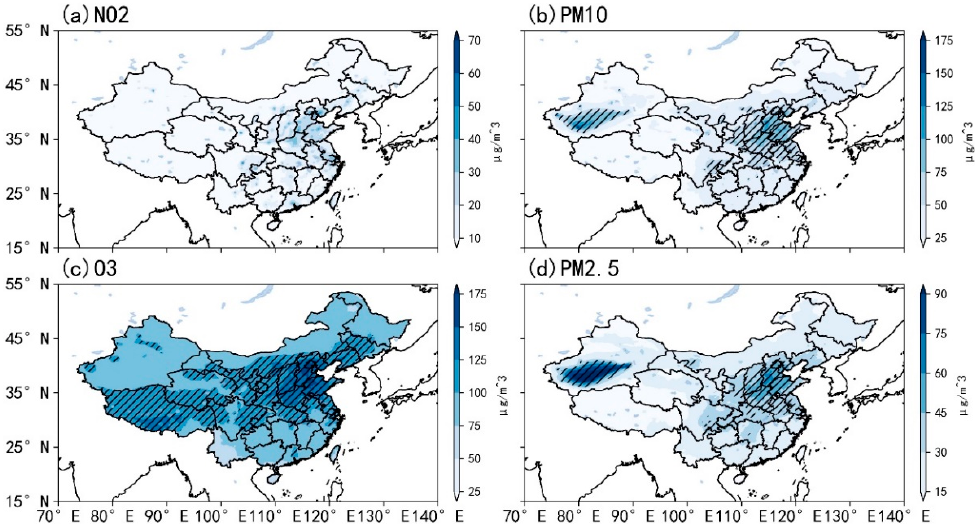
Figure 3. Season mean concentrations of air pollutants ( a ) NO 2 , ( b ) PM 10 , ( c ) O 3 (8 h maximum concentration) and ( d ) PM 2.5 in China in summer during 2013 – 2018 (unit: μ g·m − 3 , the slashed area indicates that the pollutant concentration in the area has exceeded the first-level concentration index of the Ambient Air Quality Standards in China). Table 1. Average concentration of pollutants in the Tarim Basin and the North China Plain from 2013 to 2018 (unit: μ g·m − 3 ).